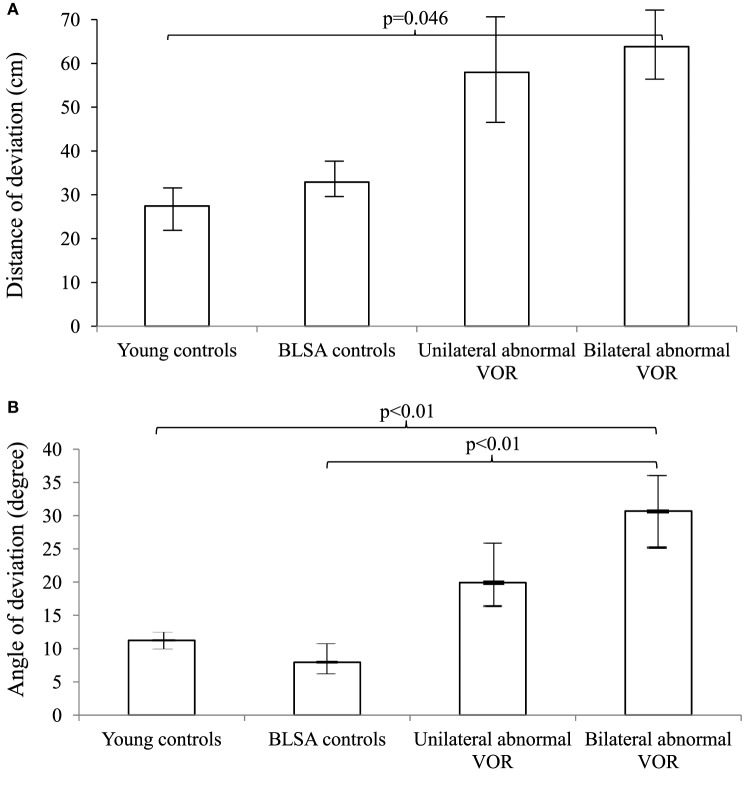
Distance (A) and angles (B) of deviation by vestibulo-ocular reflex (VOR) gain. We included 9 young controls, 15 Baltimore Longitudinal Study of Aging (BLSA) controls, and 19 Neuro-Otology Clinic patients (13 unilateral abnormal and 6 bilaterally abnormal VOR gain). An analysis of variance (ANOVA) demonstrated differences in the distance and angles across VOR categories (p = 0.03 for the distance and p < 0.01 for the angle). A pairwise post hoc analysis revealed differences that were indicated by the brackets. Error bars indicate the SEM.